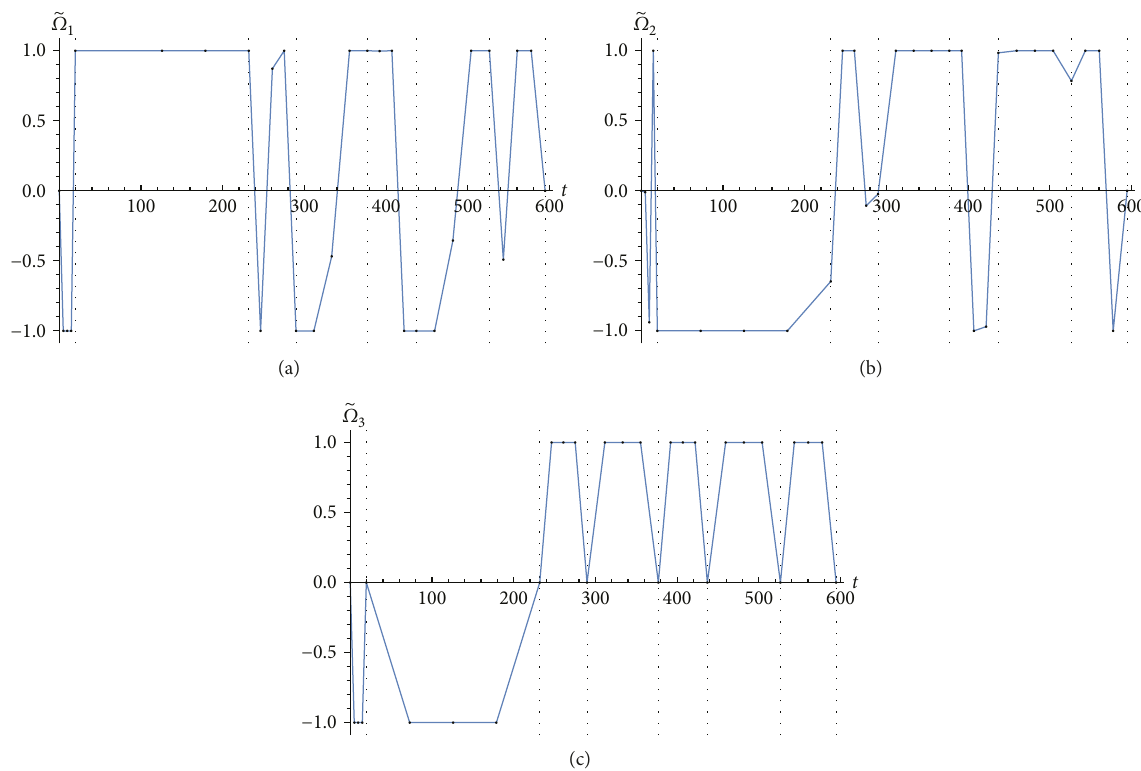
Figure 5: Angular velocities of the reaction wheels in experiment A with 6 target attitudes.